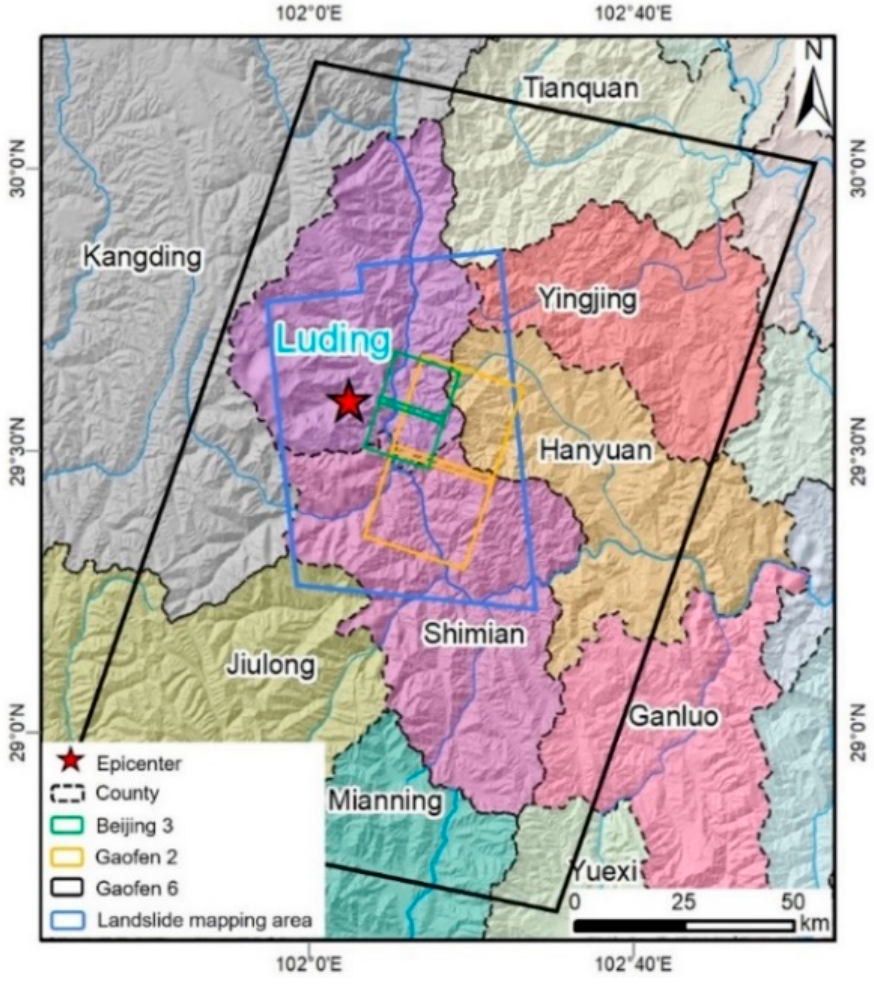
Figure 2. Coverage of satellite image.